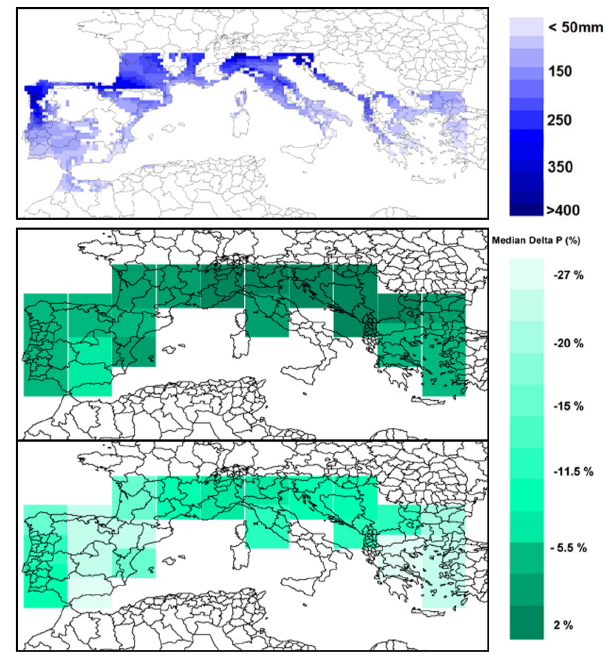
Fig. 2. Spatial distribution of present-day (1961–1990) cumulated precipitation over the period April, May, June (a) , and 50th per- centile of the probability distribution of percentage precipitation change projected for 2010–2030 (b) and 2070–2090 (c)